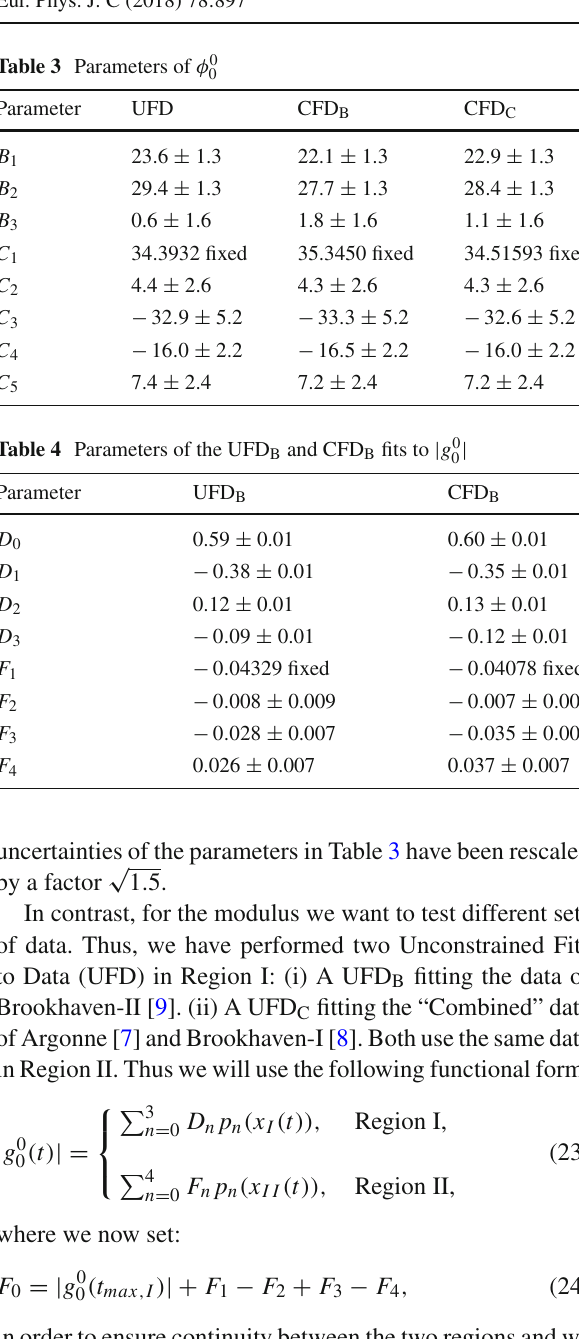
Table 5 Parameters of the UFD C and CFD C fits to | g 0